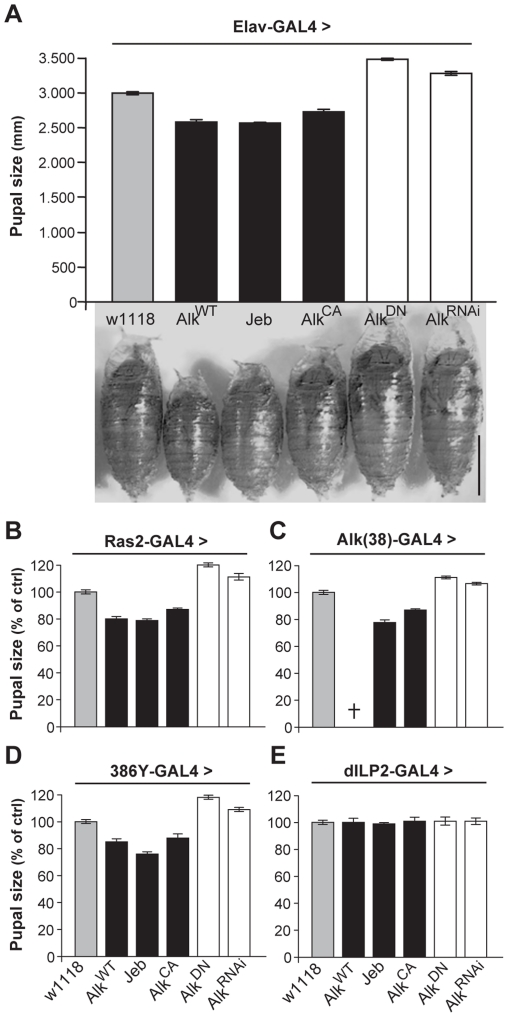
dAlk activity in Ras2-expressing neurons controls organism size.(A) Pan-neuronal activation of dAlk signaling by Elav-Gal4-driven expression of AlkWT, Jeb and AlkCA transgenes reduces pupal size, whereas abrogation of dAlk function with AlkDN or AlkRNAi expression increases pupal size relative to heterozygous driver controls (w1118) (n = 20 for each genotype). Representative pupae of each genotype are shown (Bar = 1 mm). Planned pair-wise comparisons between control and transgenic flies revealed significant differences for all genotypes (ANOVA F(5,120) = 217.62, p<0.0001). (B-E) dAlk controls size in Ras2-expressing, dAlk-expressing and neuropeptidergic cells, but not in insulin-producing cells. Significant effects of genotype on size were found with Ras2-Gal4 (n = 50), Alk(38)-Gal4 (n = 30–31) and 386Y-Gal4 (n = 16–17) (ANOVA F(5,300) = 460.97, F(5,99) = 230.03, F(5,154) = 406.05 respectively, p<0.0001), but not with dILP2-Gal4 (F(5,131) = 0.82, p = 0.53). Cross denotes larval lethality. Error bars denote S.E.M.